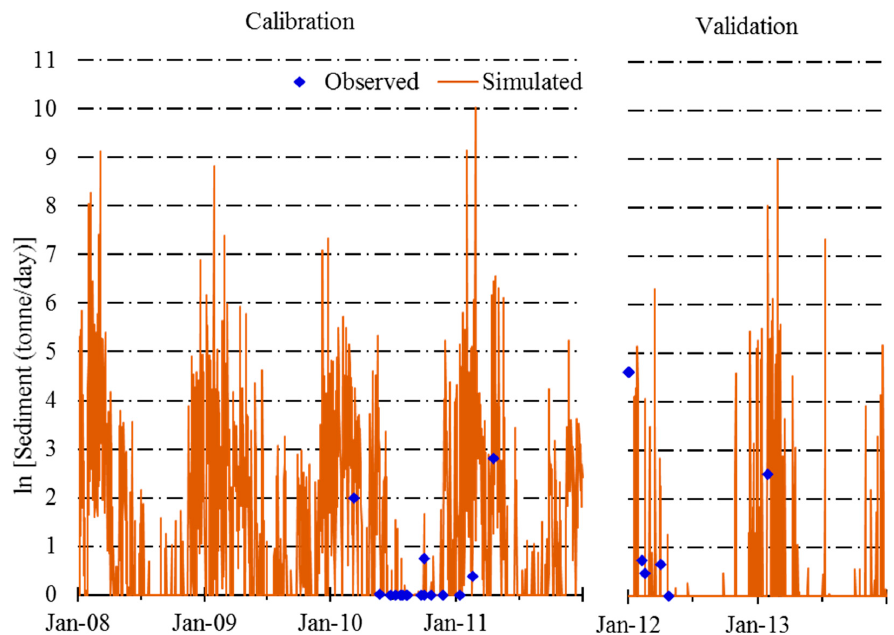
Figure 4. Calibration and validation of sediment loading to the stream.